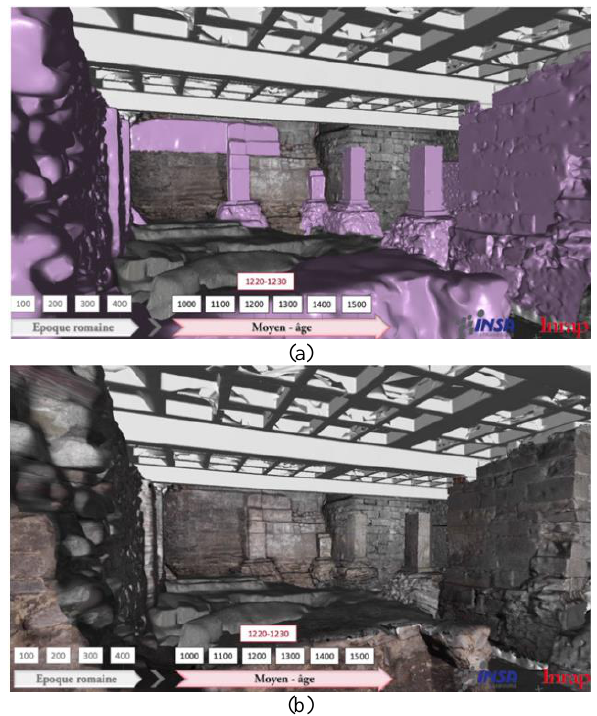
Figure 14. Virtual visit in the phased model of the basement: a) the time period is displayed simultaneously with the corresponding archaeological elements, highlighted in purple; b) as soon as the elements have been highlighted, they take the “real” color provided by the photo-realistic texture.